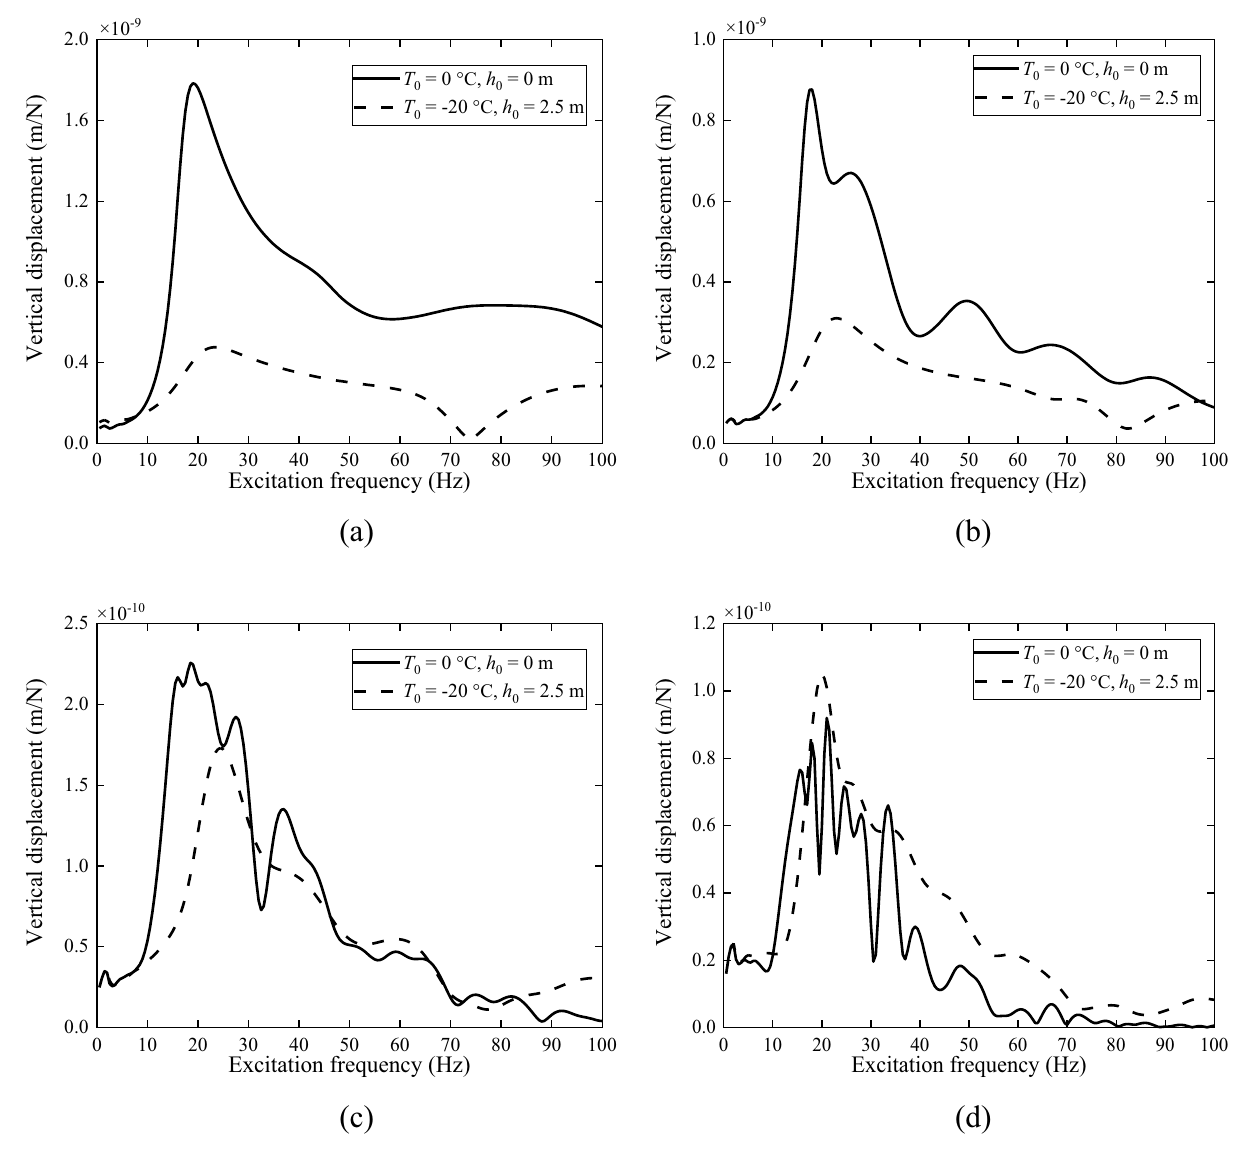
Figure 12. Vertical displacement of ground at ( a ) y = 5 m, ( b ) y = 10 m, ( c ) y = 20 m and ( d ) y = 30 m along the y -axis due to a unit point load acting at x = 0 and y = 0 with different excitation frequencies.